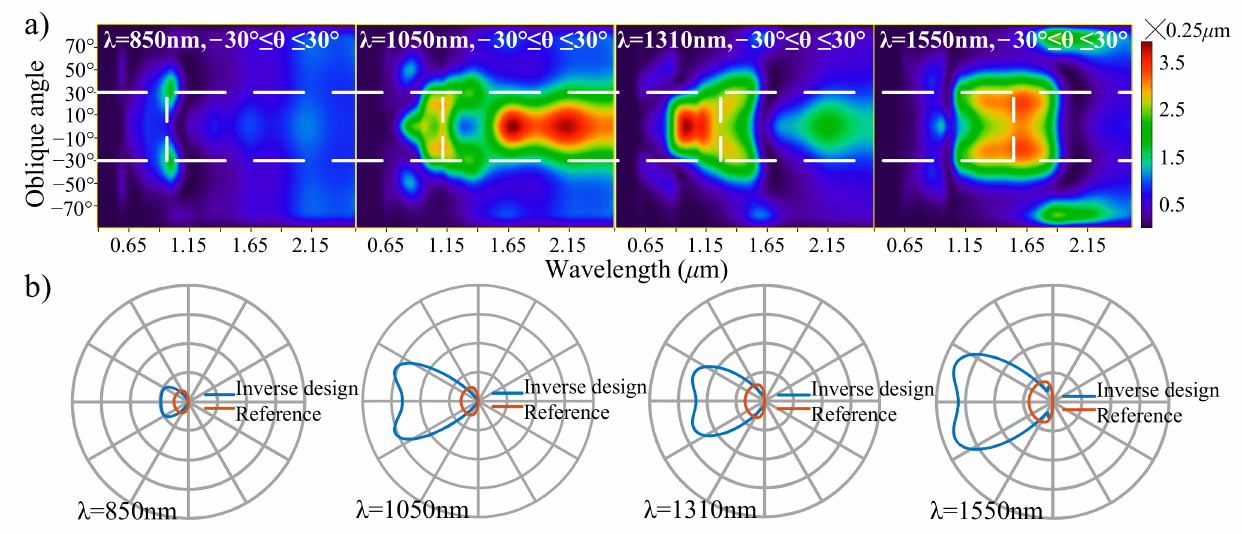
Figure 4. ( a ) Effective-aperture spectra as a function of the wavelength and oblique angle, for the four derived nanoantennas in Figure 3. ( b ) Polar diagrams of the four derived nanoantennas in Figure